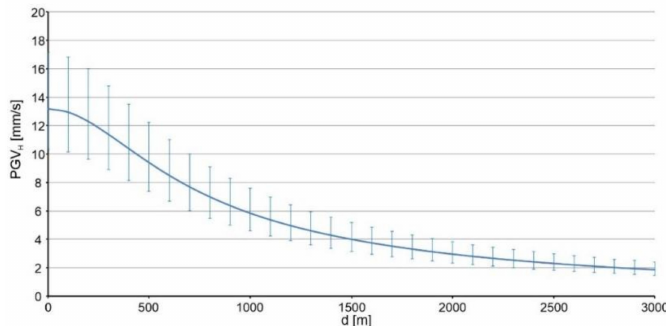
Figure 6. Theoretical values of PGV H with 90% confidence intervals for the tremor of 8 November 2018 against epicentral distance d .